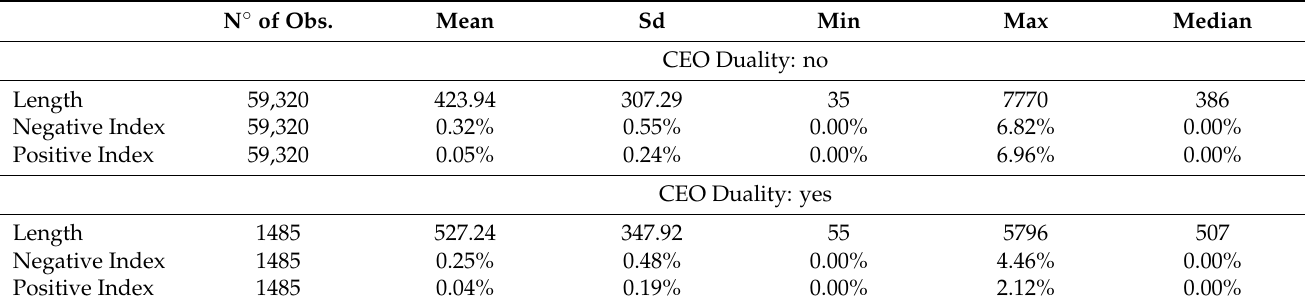
Table 4. Descriptive statistics of text-analysis